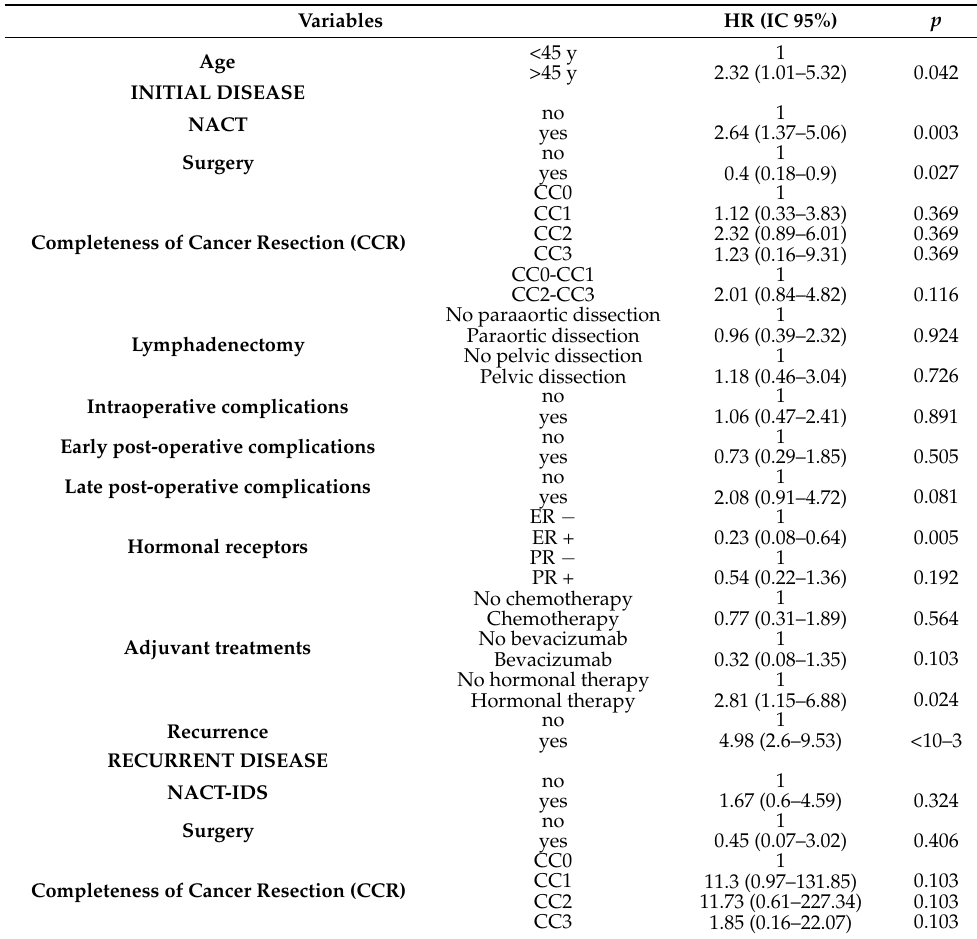
Table 6. Overall survival